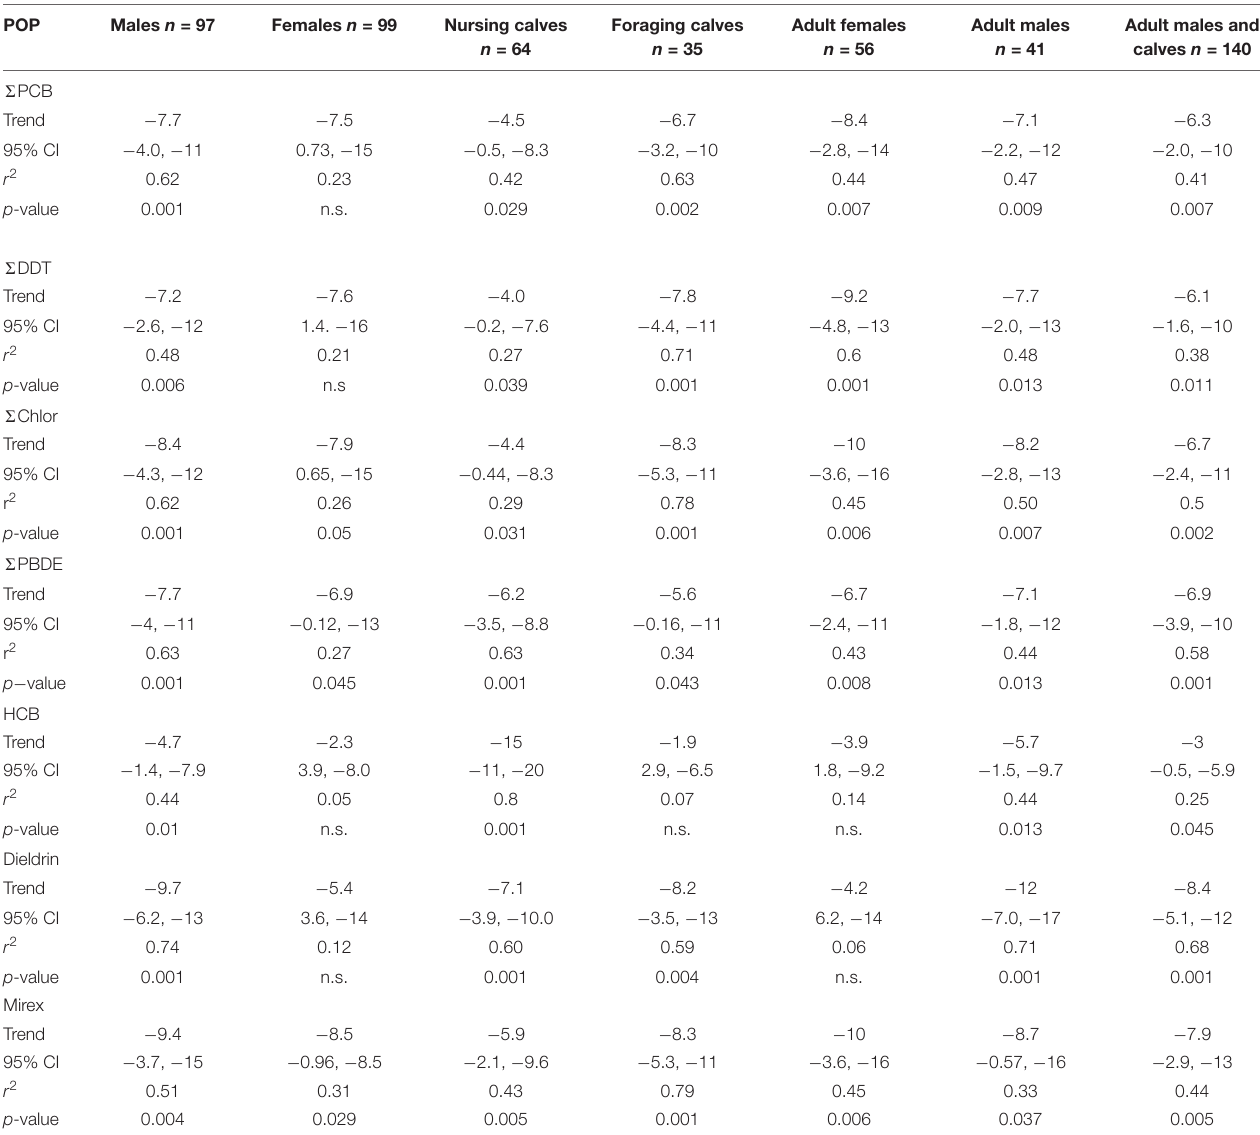
TABLE 2 | Temporal trend statistics for POP classes determined using the PIA software. POP Females n = 99 Nursing calves